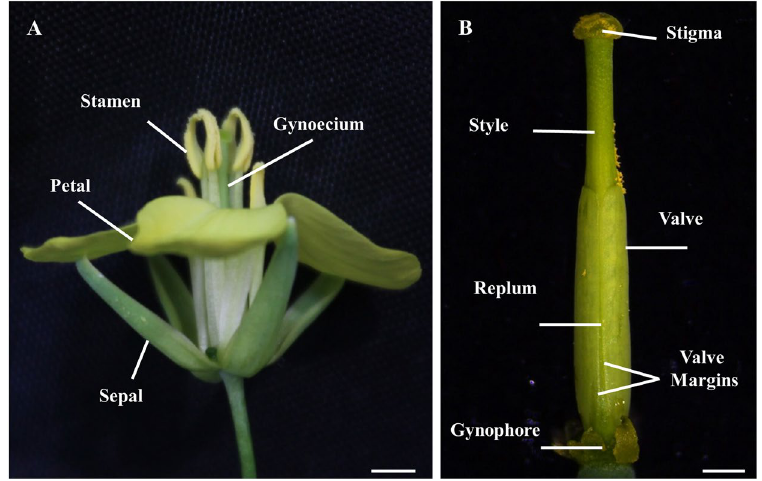
Figure 1. Overview of a Brassica napus flower and gynoecium. ( A ) Brassica napus (Canola) flower at anthesis stage. ( B ) Brassica napus gynoecium at anthesis stage. Scale bars: ( A ) 2 mm; ( B ) 1